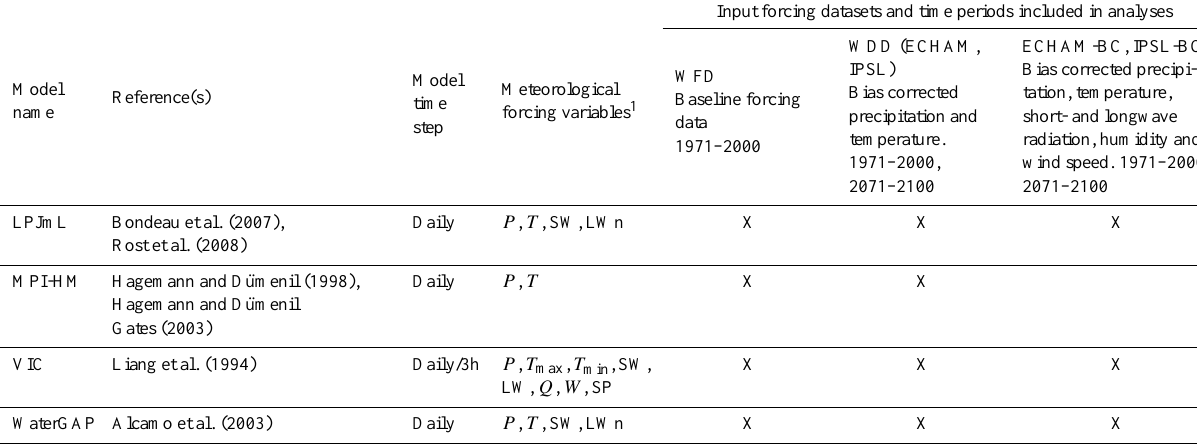
Table 1. Participating hydrological models and input forcing